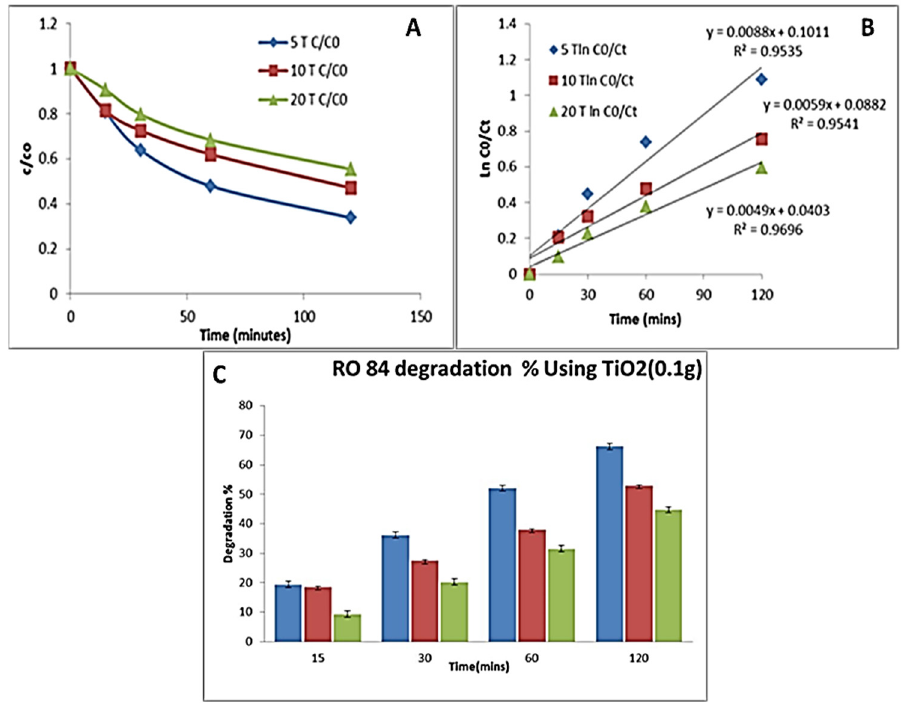
Figure 5. ( A , B ) Kinetic degradation plot of RO84 with TiO 2 (0.1 g). ( C ) Degradation % of RO84 using TiO 2 (0.1